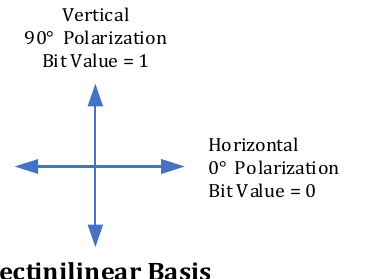
Figure 3. Classification of QKD Protocols .